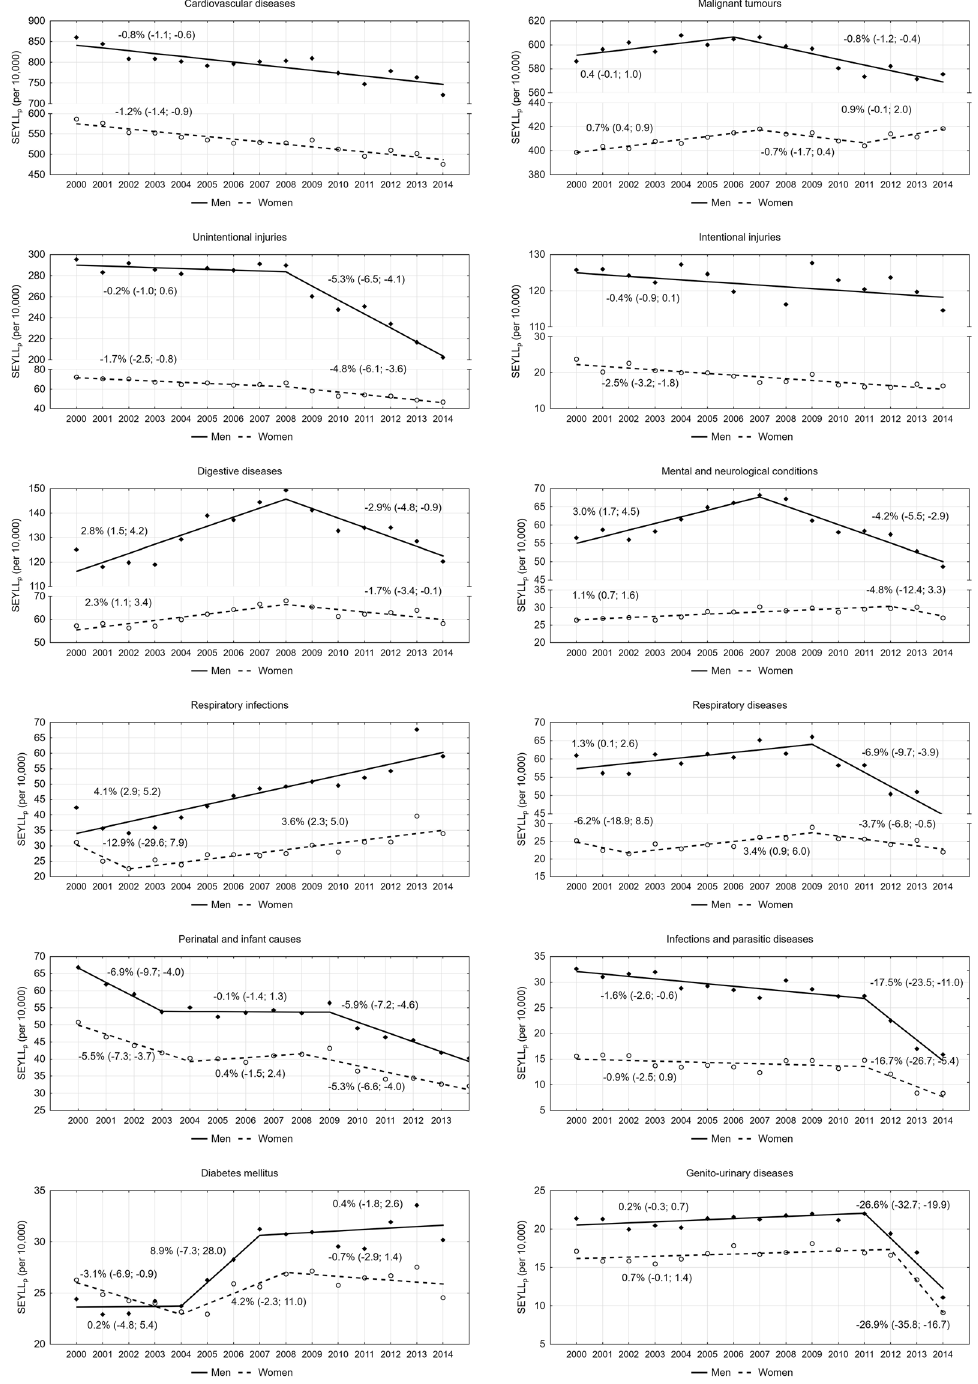
Figure 2. Time trends in SEYLL p by main groups, Poland,